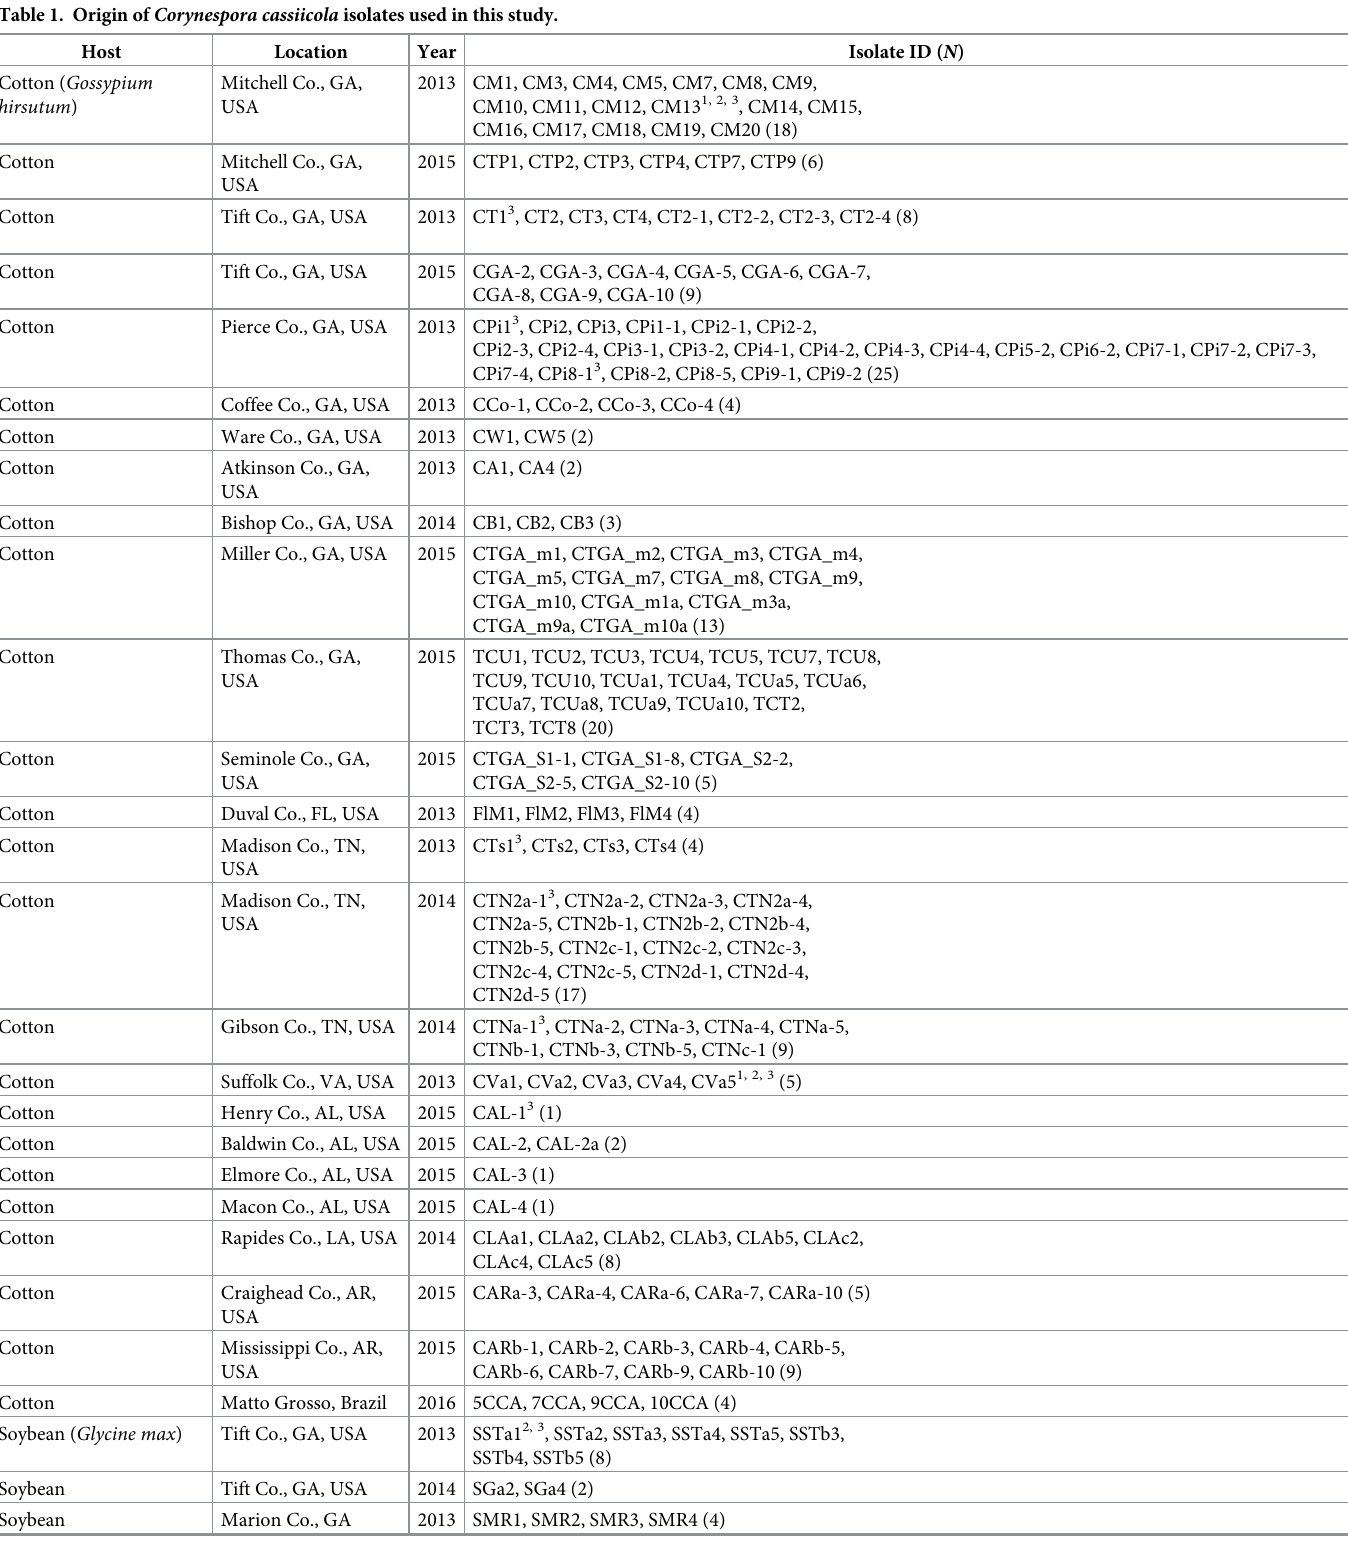
Table 1. Origin of Corynespora cassiicola isolates used in this